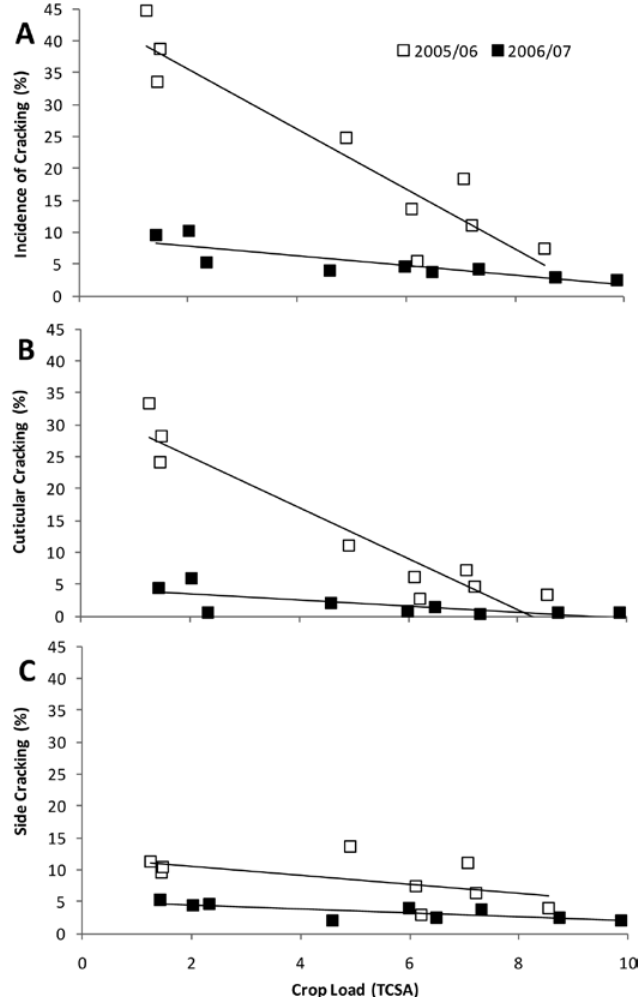
Fig. 1 - Percentage of total cracked fruit (A), cuticular-cracked fruit (B) and side-cracked fruit (C) with actual crop load (TCSA) for variety ‘Simone’. Each point is for an individual tree. A significant relationship was found between actual crop load and total cracking incidence in 2005/06 (R 2 = 0.903, P<0.001) and 2006/07 (R 2 = 0.511, P = 0.03), cuticular cracking 2005/06 (R 2 = 0.907, P<0.001) and 2006/07 (R 2 = 0.540, P = 0.02) and side cracking in 2006/07 (R 2 = 0.575, P = 0.02). A significant difference between seasons was found for total cracking and cuticular cracking. Slope (B) of the linear regressions calculated for crop load and cracking incidence were significantly different between years.